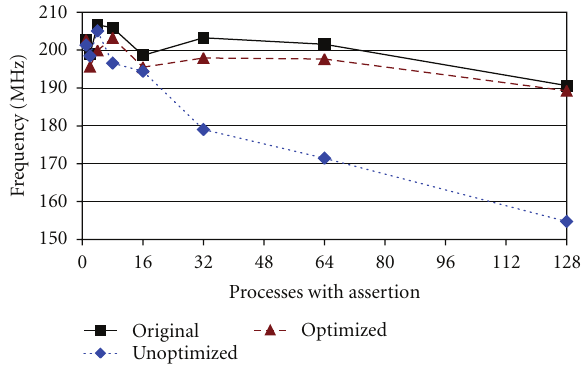
Figure 10: Assertion frequency